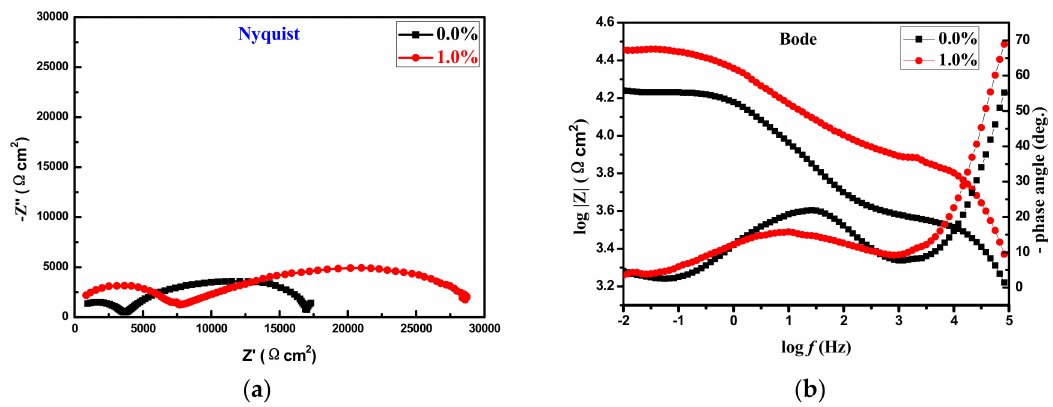
Figure 9. The Nyquist ( a ) and bode plots ( b ) of epoxy coating with 0.0% and 1.0% AT immersed in 3.5% NaCl solution after 24 h. (a) The Nyquist diagrams of epoxy coating with 0.0% and 1.0% AT immersed in 3.5% NaCl solution after 24 h; (b) The bode plots of epoxy coating with 0.0% and 1.0% AT immersed in 3.5% NaCl solution after 24